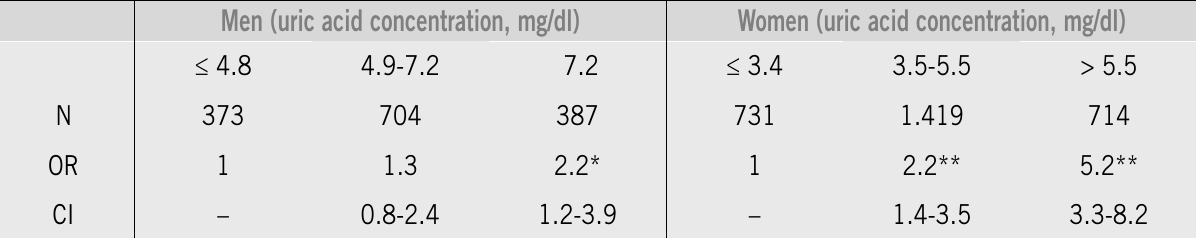
Odds ratio (95% CI) for the association between the laboratory profile of metabolic syndrome and serum concentration of uric acid in unselected Brazilian ambulatory patients aged 20-102 years Men (uric acid concentration,